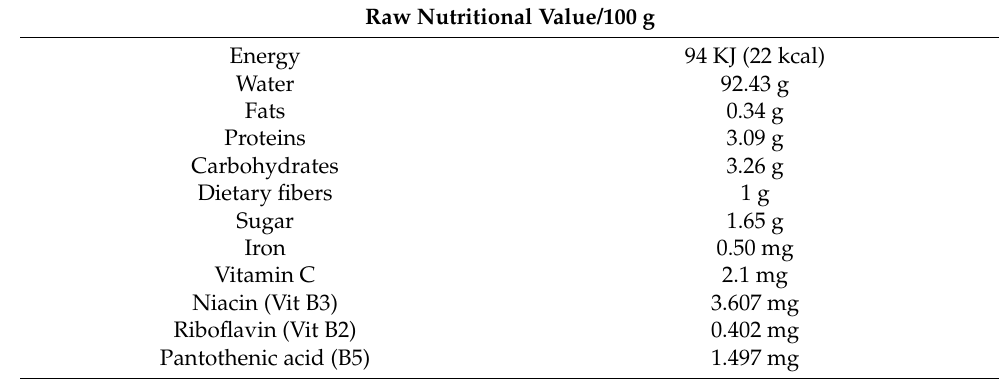
Table 1. Nutritional status of A. bisporus .